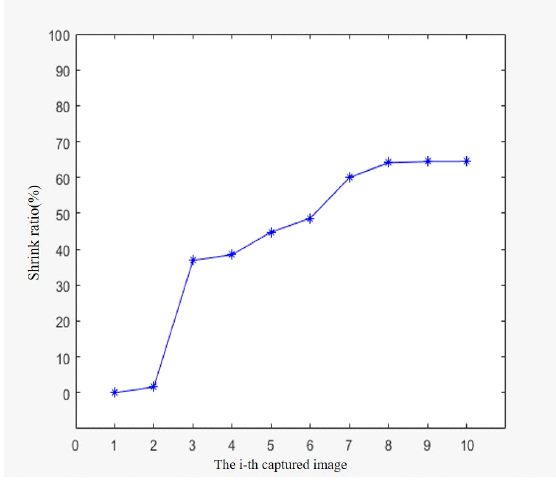
Figure 4. The relationship between the ten times of image acquisition and its shrinkage ratio.